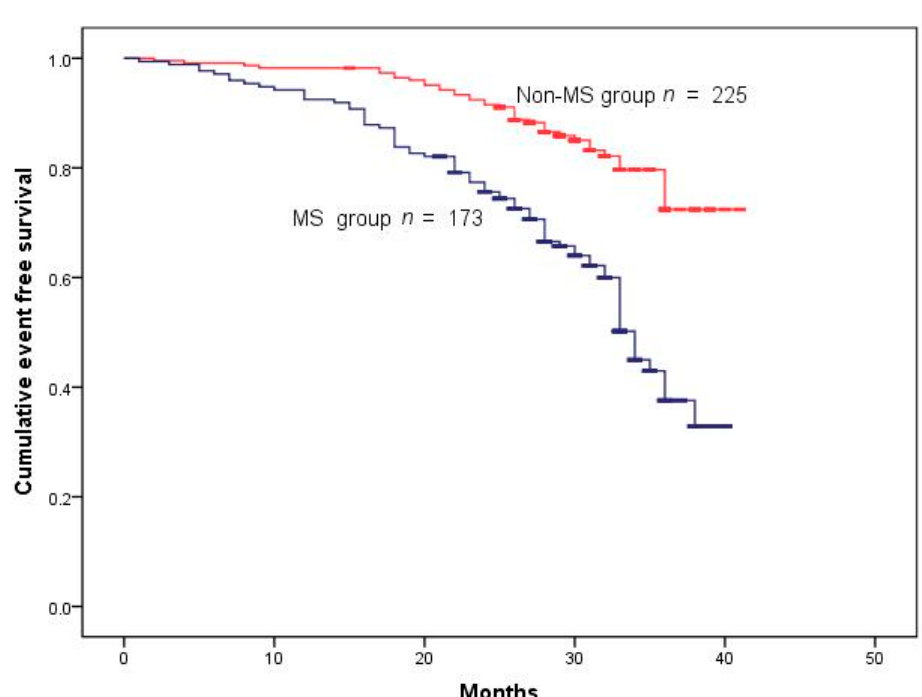
Figure 2. Cumulative survival rates censored for MACE. Survival was reduced in patients with MS (log-rank test p < 0.001).